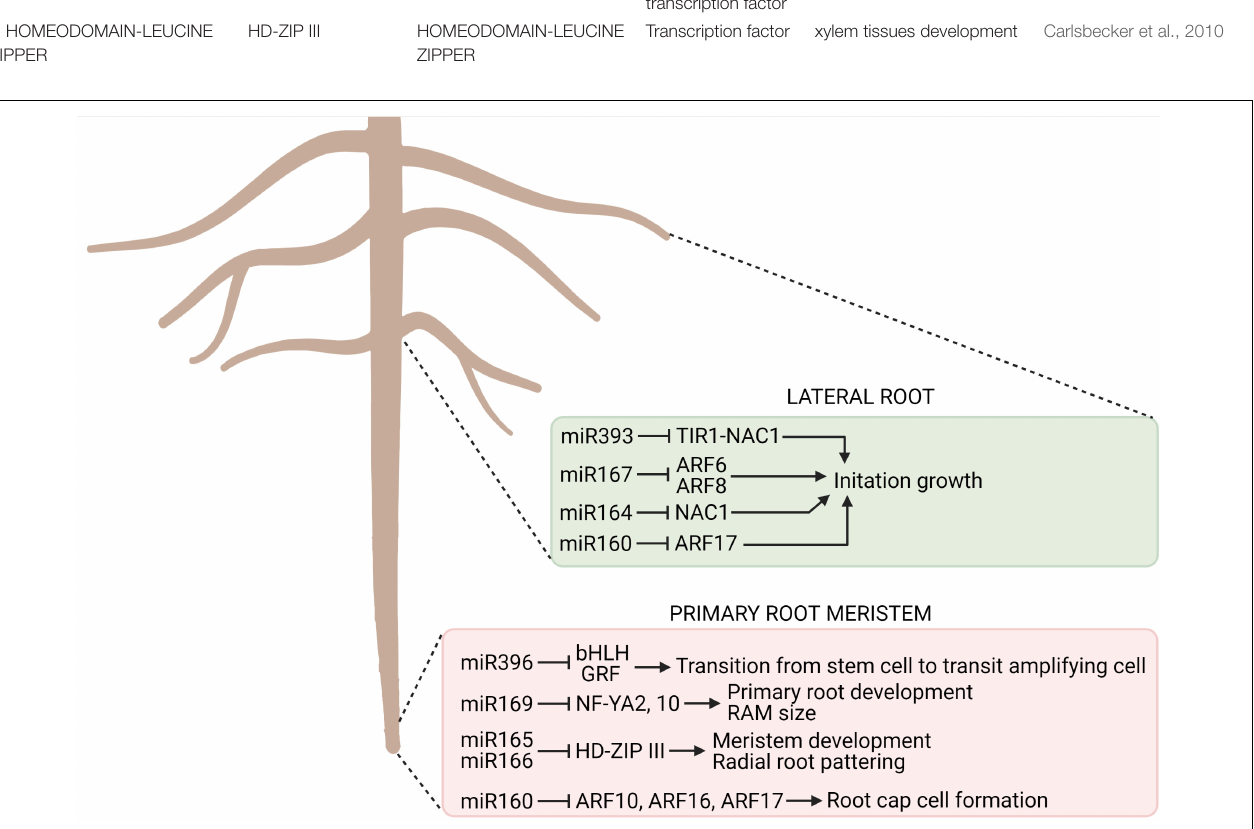
FIGURE 3 | The key miRNAs involved in root development. For each type of structure, the implicated miRNA, their targets, and the process they control are indicated in the colored boxes. TIR, TRANSPORT INHIBITOR RESPONSE; ARF, AUXIN RESPONSE FACTOR; NAC, NO APICAL MERISTEM, ARABIDOPSIS TRANSCRIPTION ACTIVATION FACTOR (NAM, ATAF, CUC); bHLH, helix-loop-helix; GRF, GROWTH REGULATING FACTOR; HD-ZIP, HOMEODOMAIN LEUCINE ZIPPER; NF-YA, NUCLEAR FACTOR-YA [based on Couzigou and Combier (2016)]. Created with